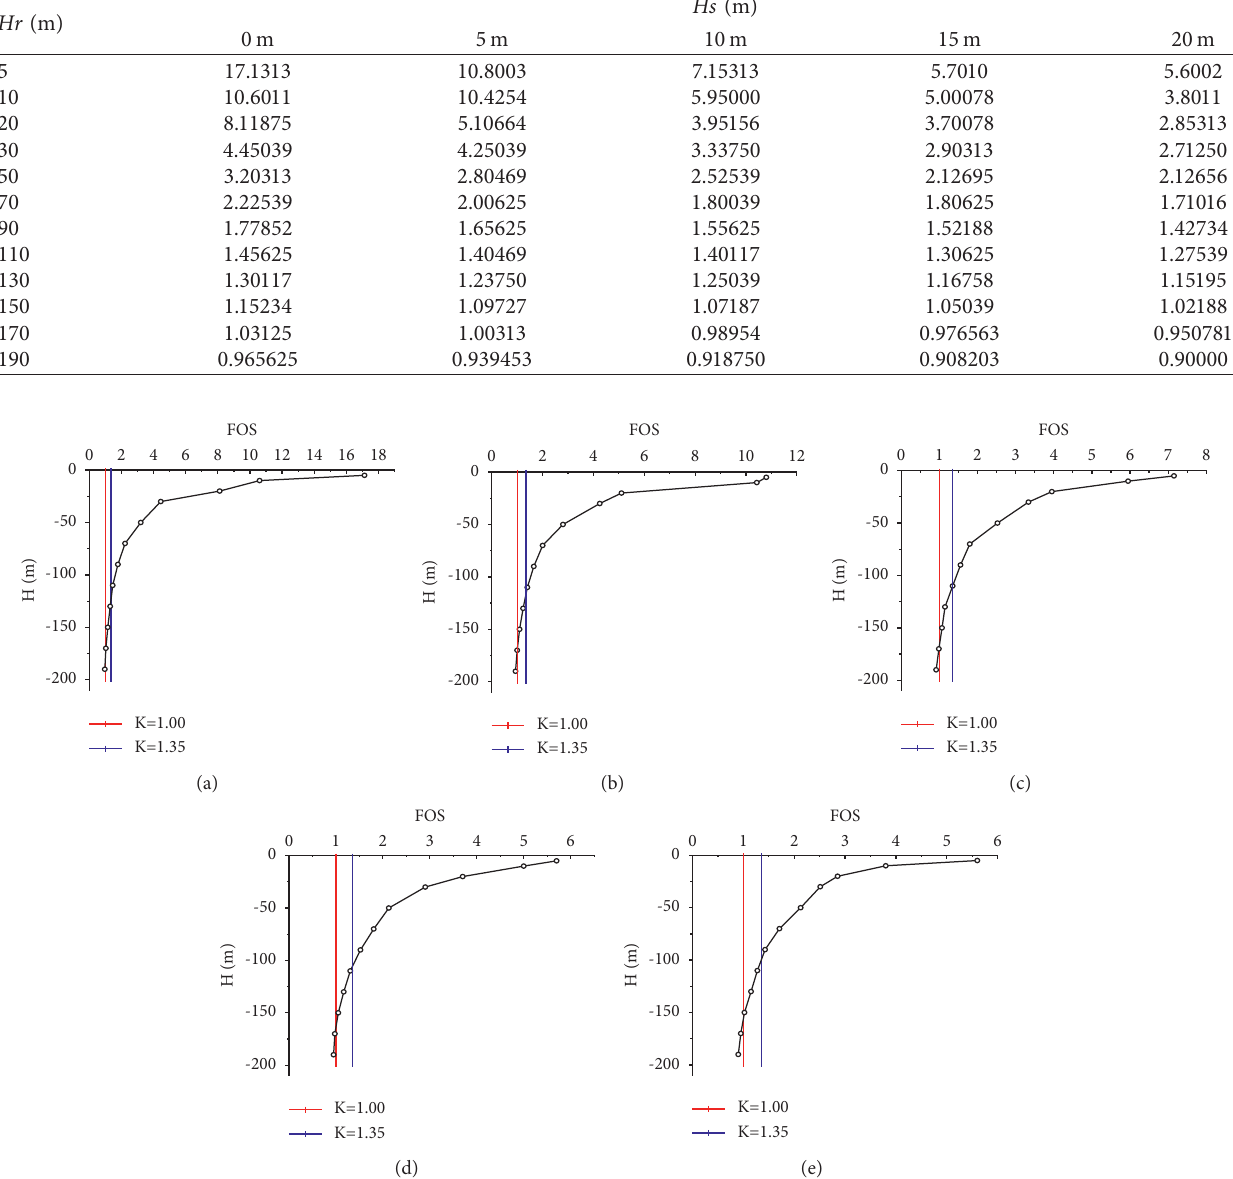
Table 6: Calculation results of deep foundation pit vertical rock wall FOS.